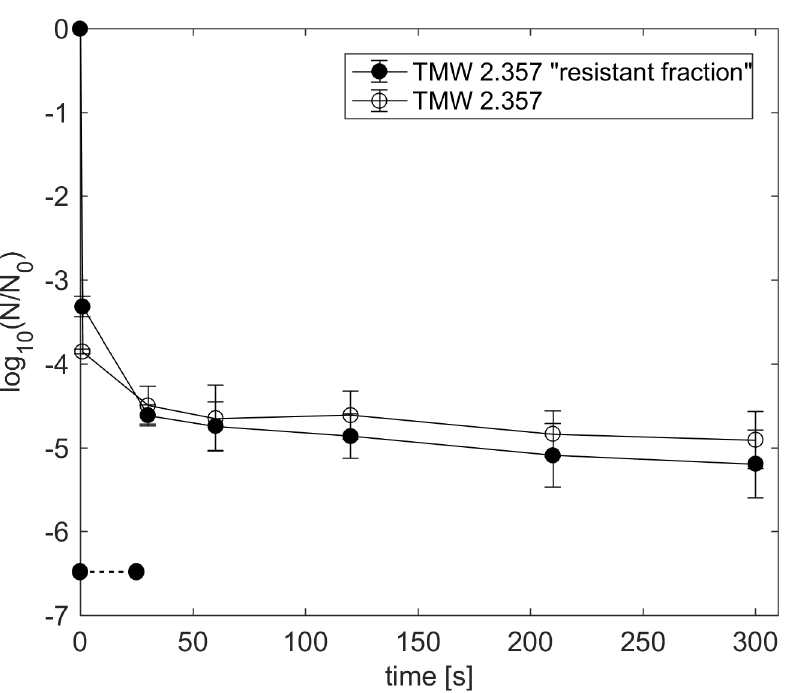
Fig 5. Inactivation of C . botulinum TMW 2.357 spores at 600 MPa and 110˚C in green peas with ham. Solid circles indicate spores producedfrom the resistant fraction survivingHPT treatment at 600 MPa, 110˚C for 300 s. Open circles indicatespores producedusing the standard procedure. Data are shown as means ± standard deviations of at least duplicateindependent experiments.